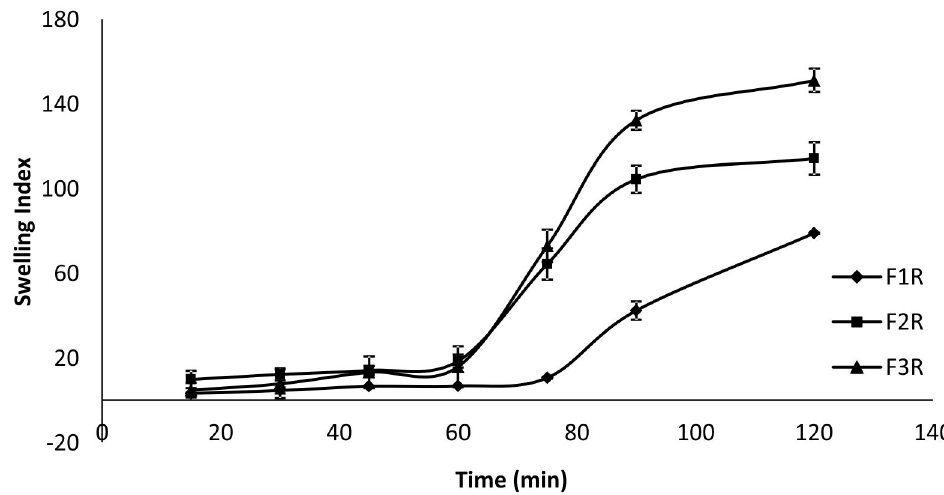
FIGURE 2 - Swelling index (mean ± SD,